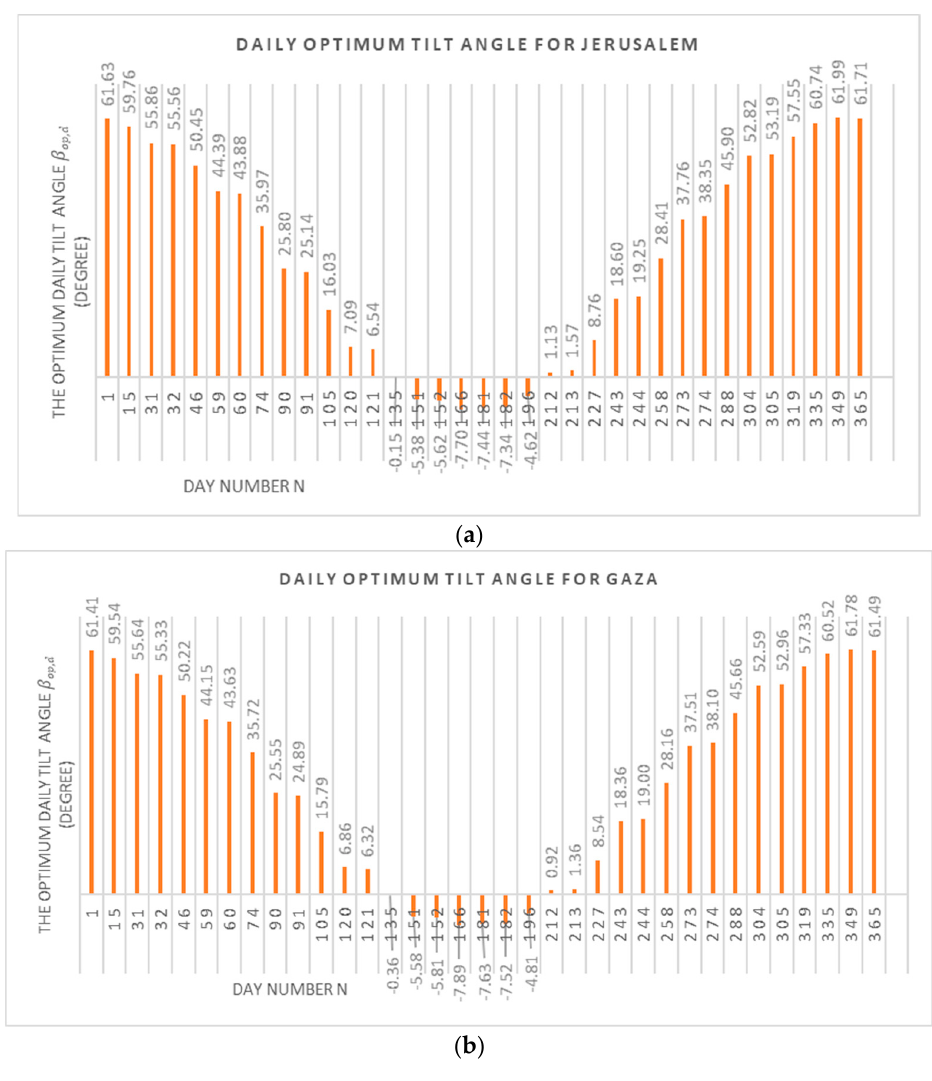
Figure 4. The daily optimum tilt angle β opt,d for Jerusalem ( a ) and Gaza City ( b ).